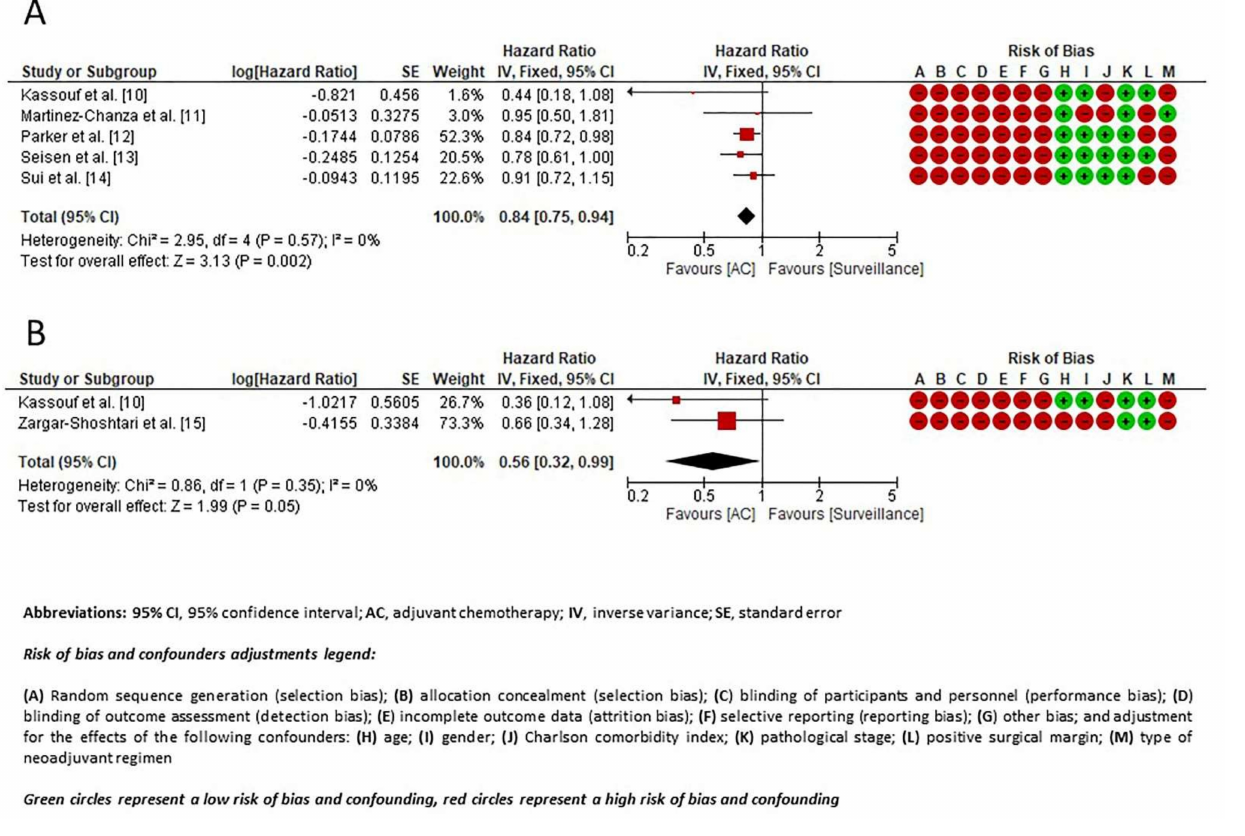
Figure 2. Forest plot of the hazard ratio for ( A ) overall survival, and ( B ) disease-specific survival. Data for DSS were reported in two studies [10,15]. No significant heterogeneity was observed among the studies (I 2 = 0%; p = 0.35). Therefore, a fixed-effect model was used. A forest plot of HR and 95% CI for OS is presented in Figure 2B. Receiving AC was associated with significantly better DSS (HR 0.56, 95% CI 0.32–0.99; p = 0.05) in the pooled analysis. The funnel plot revealed no publication bias (Figure